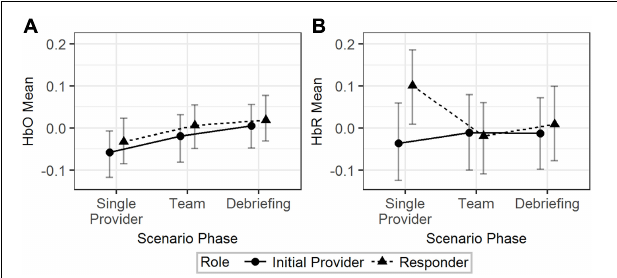
FIGURE 3 | The predicted means and 95% HDIs of the initial provider and the responder’s HbO (A) and HbR (B) levels at different scenario phases. The values of all the other variables were held at their means.